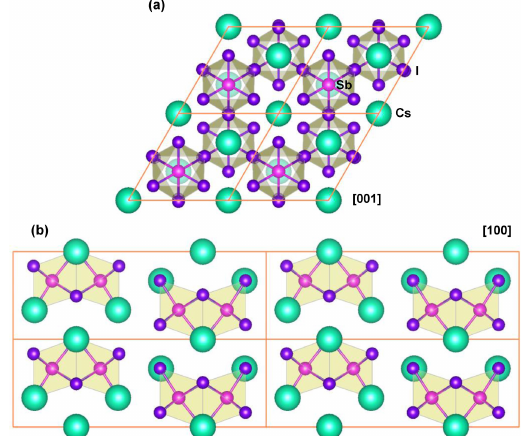
Figure 27: Structural models of Rb 2 SnCl 6 with 0-dimensional per- ovskite structures, observed along (a) [100], (b) [110], and (c) [111]. (d) Perspective view of the structure.